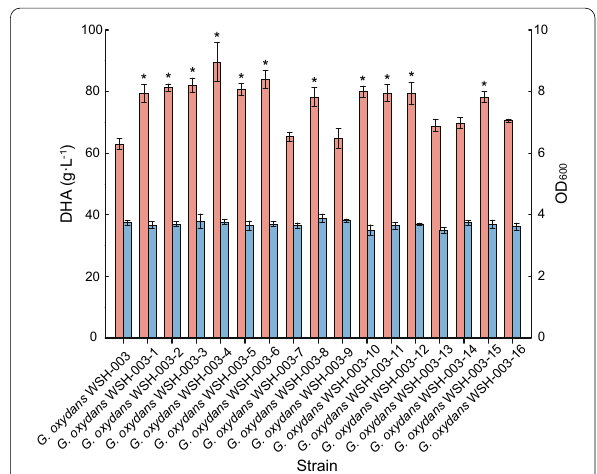
(Fig. 3A). After seed culture medium optimization, the addition of two cheaper nitrogen sources (yeast extract and corn steep liquor) to fermentation medium, and their effects on DHA production, were compared with origi- nal yeast extract powder. A relatively higher DHA titer was determined with yeast extract as the nitrogen source;